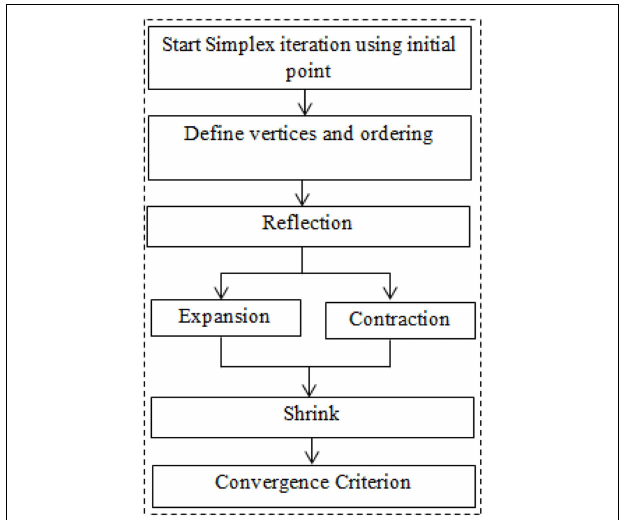
FIGURE 2 | Schematic of Nelder–Mead simplex